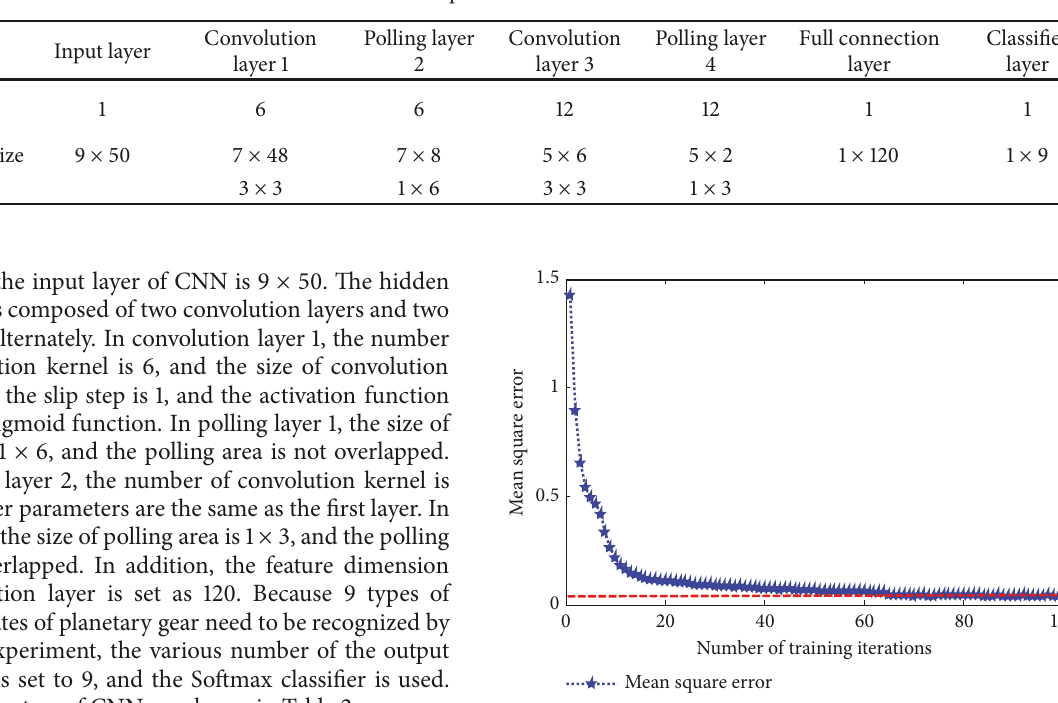
Table 2: Basic parameters of CNN.